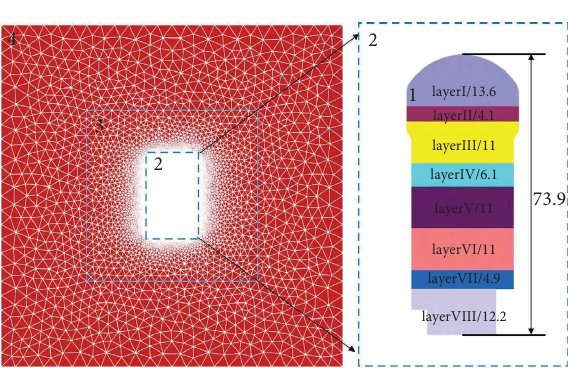
Figure 3: Model of numerical